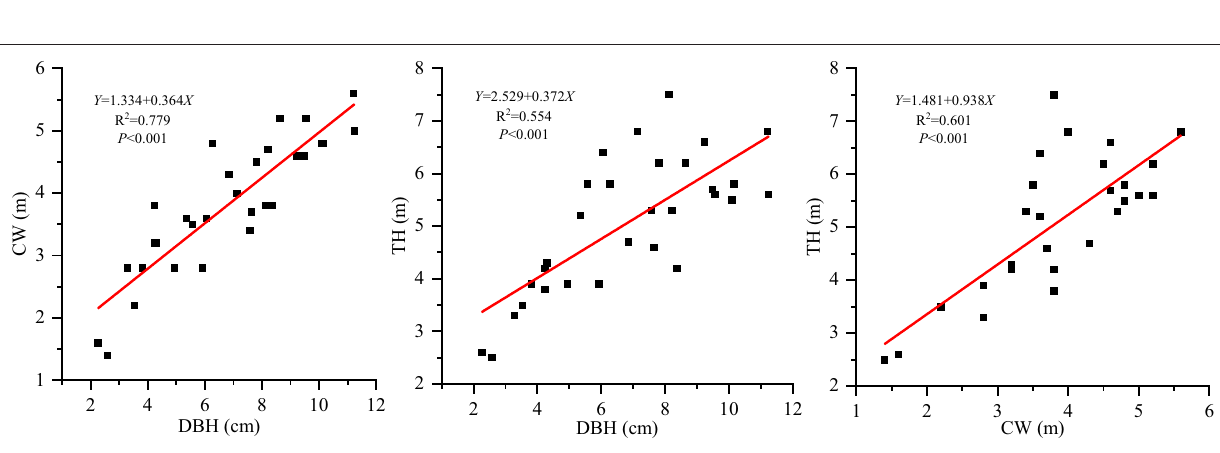
FIGURE 3 | Correlations among leaf structural traits of Sapindus mukorossi . Correlation coefficients of the blue and red ellipses are positive and negative, respectively. Darker the color and smaller the area of the ellipse, greater the degree of correlation, and larger the absolute value of correlation coefficient. Variable names are on the diagonal. ** p < 0.01.